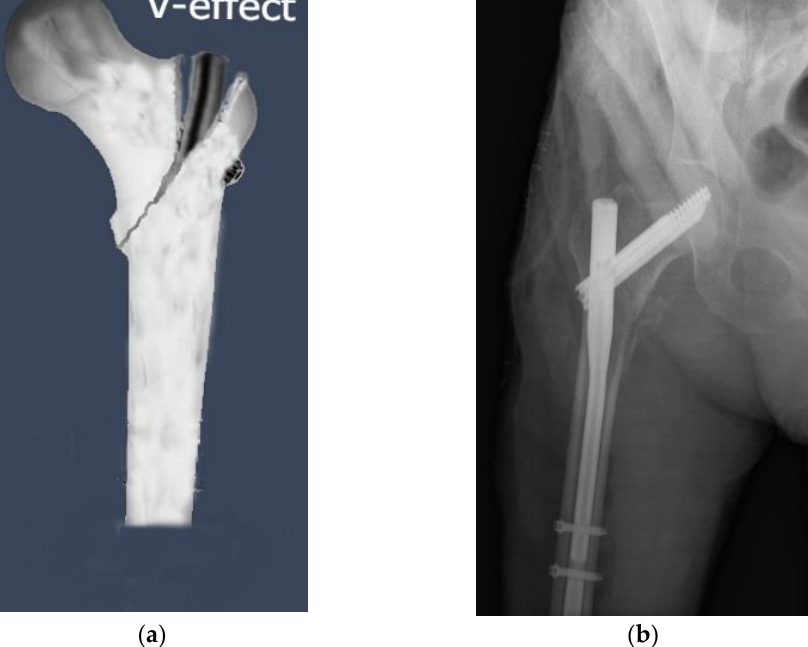
Figure 2. The ‘’V-effect”, an iatrogenic complication of proximal femoral nail fixation in intertrochanteric femoral fractures, may develop when the fracture line extends all the way to the greater trochanteric tip. ( a ) An illustration of the “V-effect”. ( b ) Observation of the V-effect in a patient who underwent surgery with A-PFN nail.